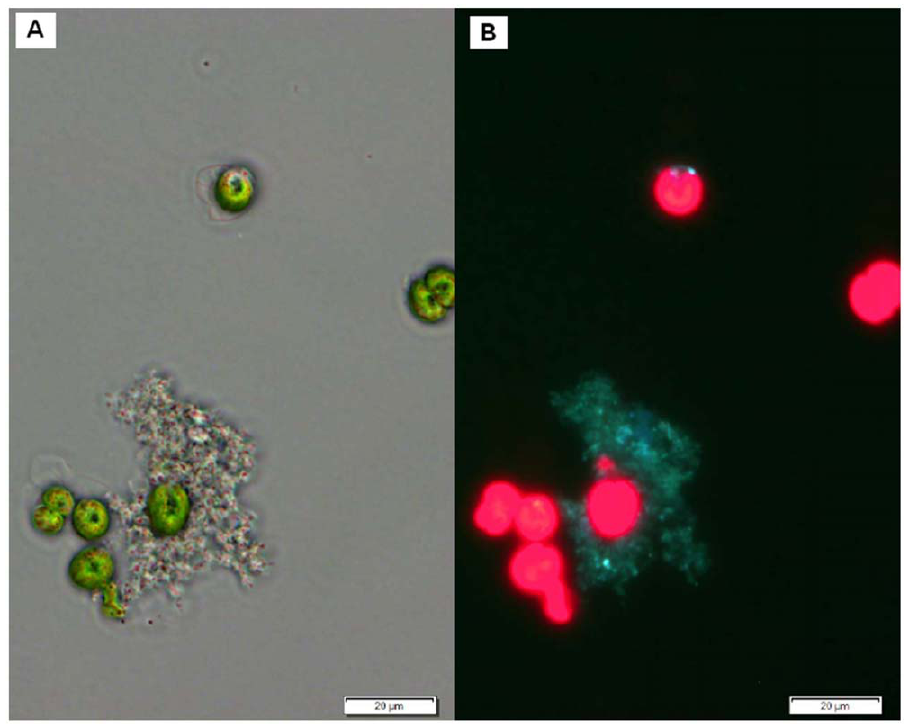
Figure 4. Expression of tdaC in co-culture with Tetraselmissuecica . Phase contrast (A) and fluorescence (B) micrographs of P. gallaeciensis pPDA11 ( tdaCp::gfp ) in co-culture with T. suecica . The two panels show the same seven algal cells of which some are dividing, and a marine snow-like particle which is colonized by P. gallaeciensis carrying the promoter-fusion on a plasmid. The green fluorescence of P. gallaeciensis on the particle shows that the gfp gene is expressed from the tdaC promoter, indicating production of TDA.